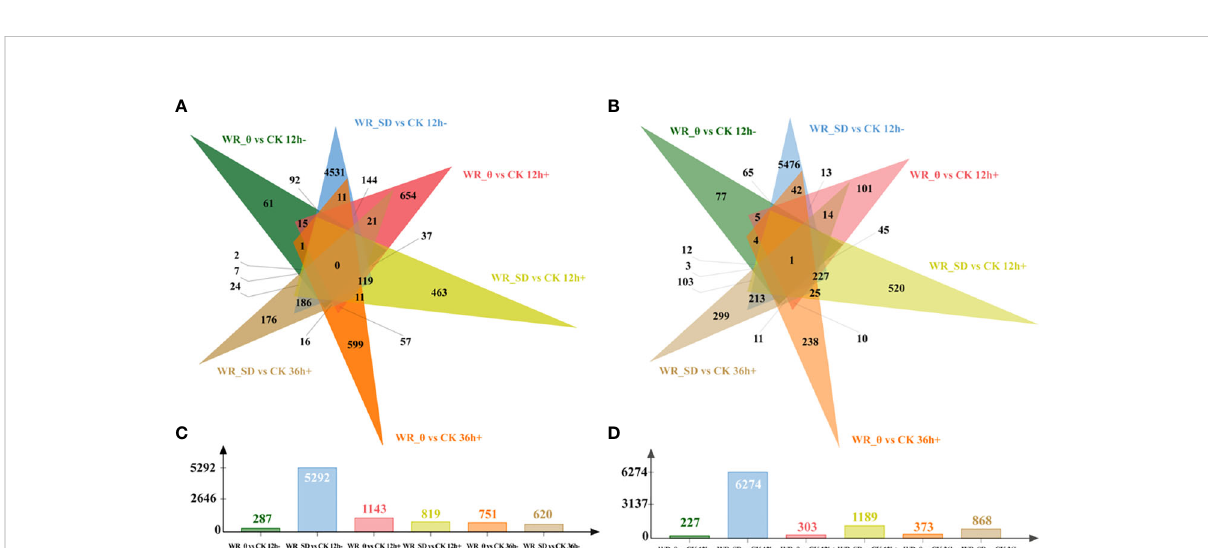
FIGURE 5 Overview of DEGs before and after water recovery. a-b, Venn diagrams for upregulated (A) and downregulated (B) DEGs of pairwise comparisons within the entire WR_ q cri vs. CK set and WR_SD vs. CK. c-d, Number of upregulated (C) and downregulated (D) DEGs of pairwise comparisons within the entire WR_ q cri vs. CK set and WR_SD vs. CK. “ CK 12 h-, WR_ q cri 12 h-, WR_SD 12 h- ” , “ CK 12 h+, WR_ q cri 12 h+, WR_SD 12 h+ ” , and “ CK 36 h+, WR_ q cri 36 h+, WR_SD 36 h+ ” indicate samples obtained at 12 h before, 12 h after and 36 h after water recovery in the CK, WR_ q cri , and WR_SD treatments, respectively.